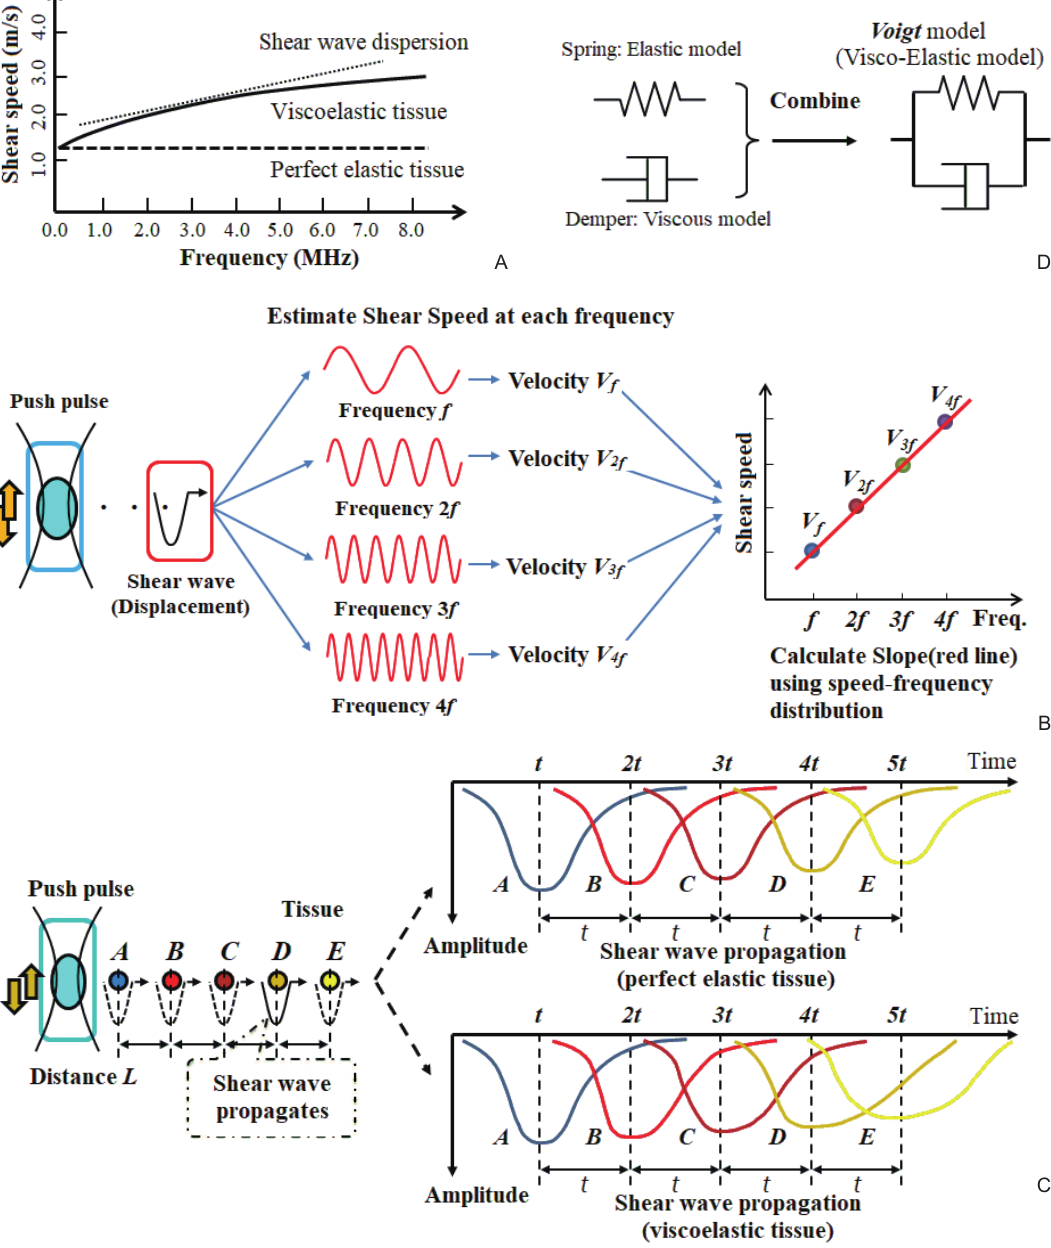
Figure 2 Properties of shear wave dispersion: Basics and applications. (A) Voigt’s shear wave viscoelastic model; (B) The relationship between pulse wave frequency and tissue shear wave; (C) The assessment of shear wave elastic modulus; (D) Shear wave dispersion.